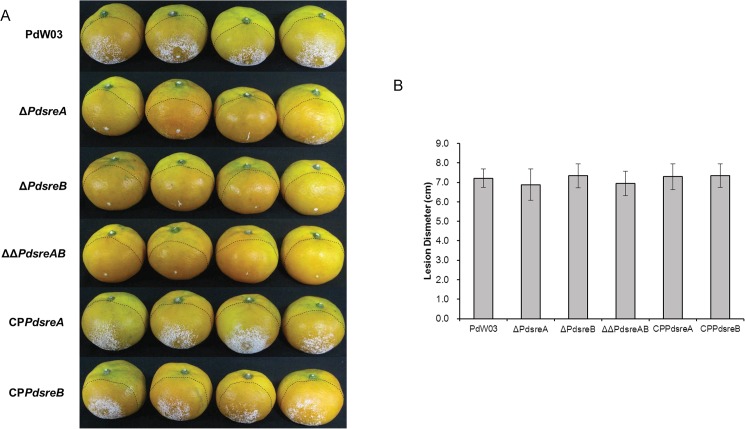
Infection assays of the wild-type PdW03 and SREBP mutants.(A) Decay symptoms in citrus fruits inoculated with the indicated strains, and incubated at room temperature for 4 days. (B) Average diameter of the macerated lesions in citrus fruits. Dashed lines denote the lesion diameter.